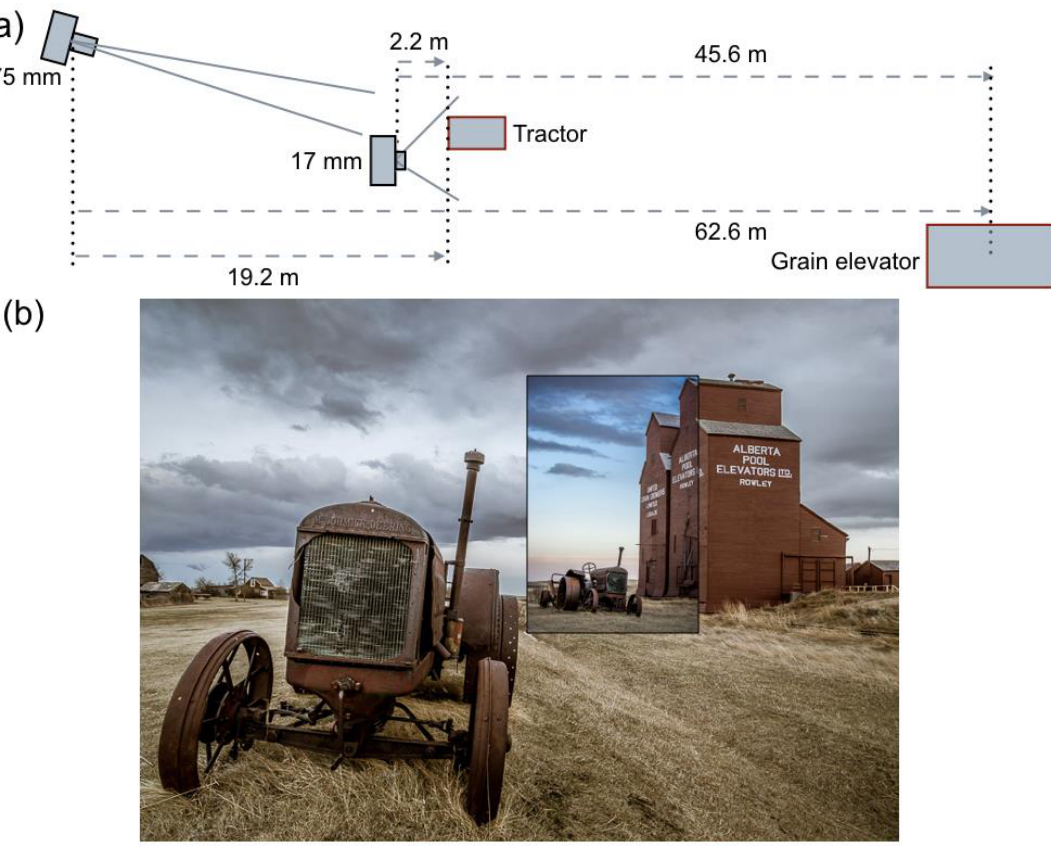
Figure 8. ( a ) Geometry of the physical scene. ( b ) Figure 7a is shown here with Figure 7b on top. Figure 7b has been resized such that the grain elevator is depicted at the same scale in both